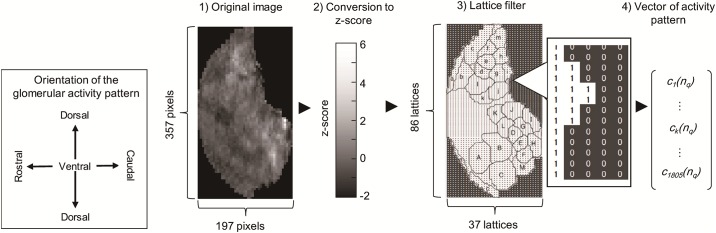
Method of generating the model input from measured glomerular activity patterns provided by a web database (http://gara.bio.uci.edu/) (adapted from [5]).The original image of the glomerular activity pattern (left) is composed of 357 × 197 pixels, and the grayscale of each pixel corresponds to the activity strength. The original image is divided into 1805 lattices, approximately equal to the actual number of glomeruli distributed on the olfactory bulb. The average activity strength is calculated for each pixel and converted into a vector representing an activity pattern.